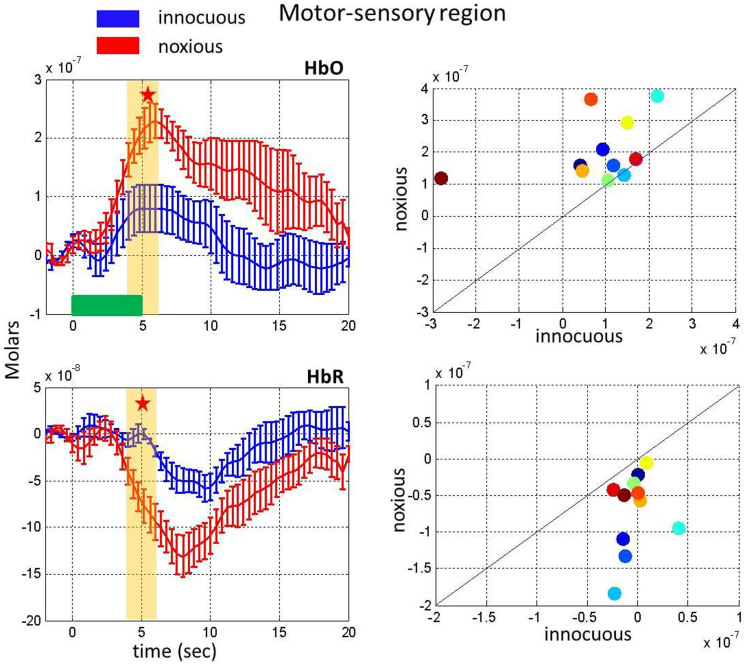
Comparison of the hemodynamic response to innocuous and noxious stimuli in the first three minutes on the motor-sensory region.Changes in HbO (top, left) and HbR (bottom, left) as a response to innocuous stimuli (blue) and noxious stimuli (red). Yellow bars show the interval chosen to obtain the mean responses depicted in the scatter plots and stars indicate a statistically significant difference. The right panels show a scatter plot comparing the hemodynamic response for each subject averaged over the yellow bar during the first three minutes for HbO (top) and HbR (bottom). The horizontal green bar shows the stimulus duration.